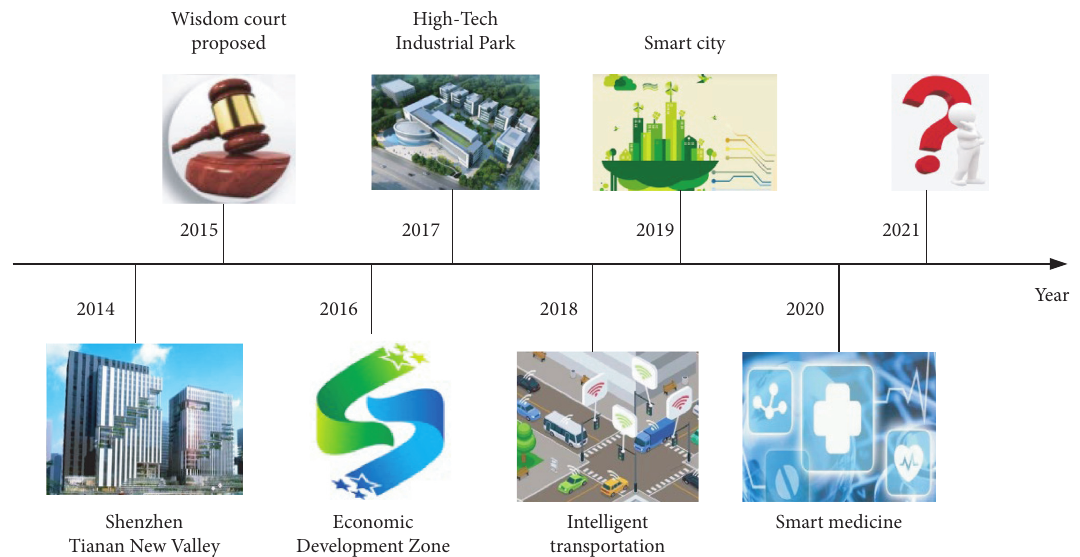
Figure 1: A schematic diagram of the development trend of intelligent parks in